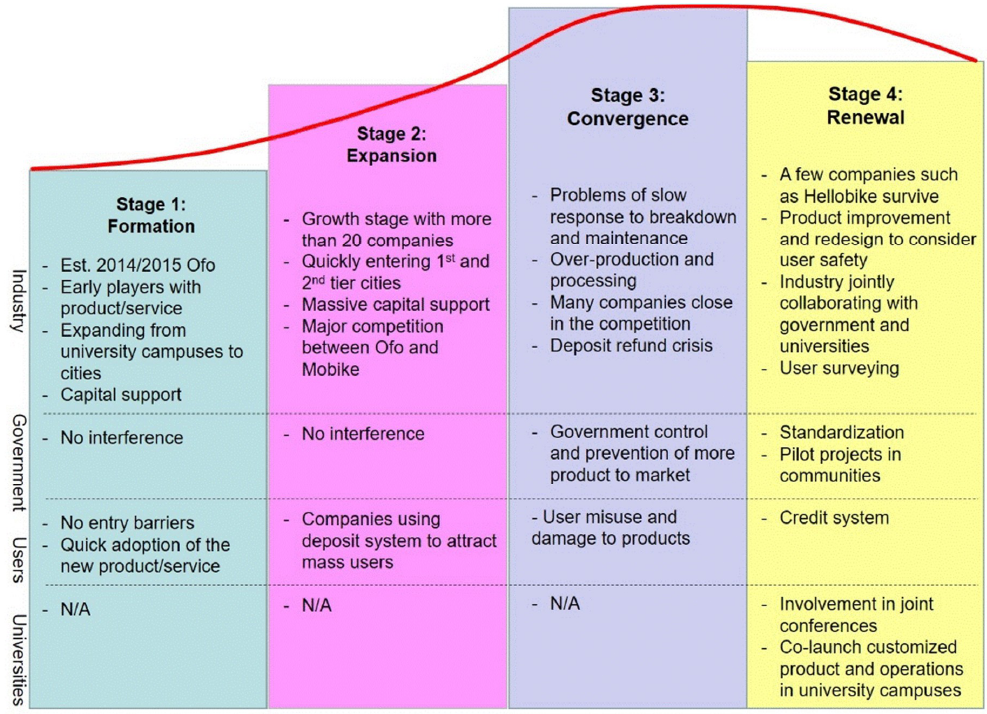
Figure 2. Life cycle of China’s shared bicycle